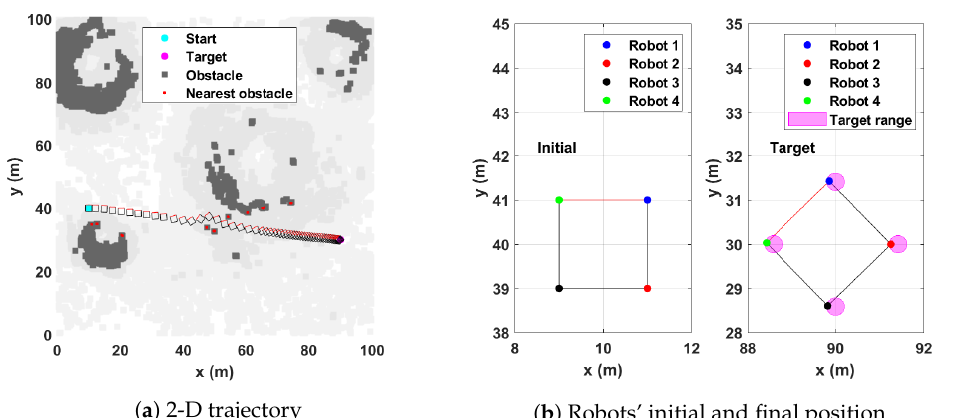
Figure 12. Testing results: Case 2.